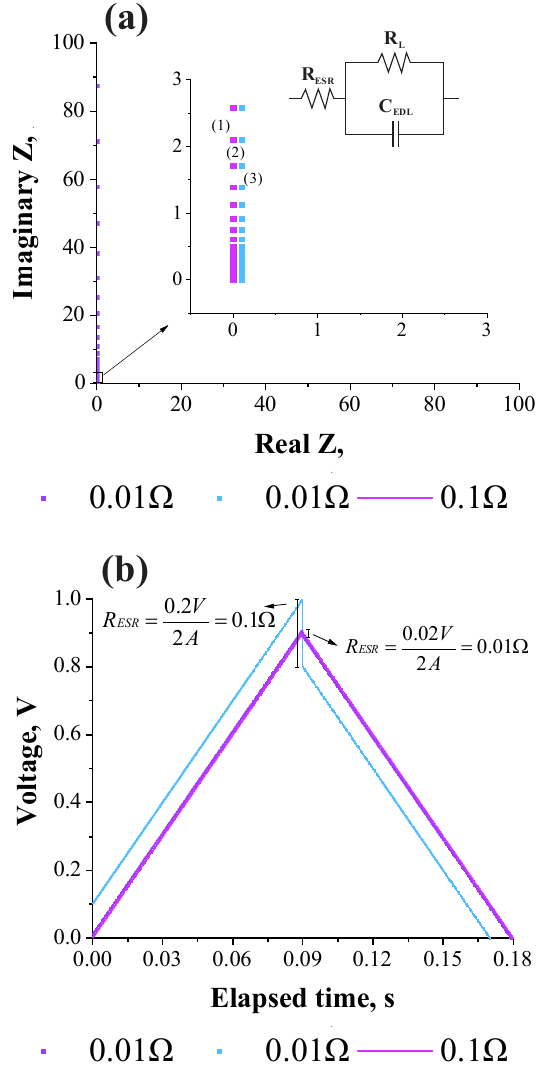
Figure 1. Schematic representation of ( a ) the complex-plane plots and ( b ) the galvanostatic charge-discharge curves evidencing the voltage drop ( U drop ). The inset in Figure 1a shows the canonic circuit model. Simulation was carried out considering different values of the R ESR and R L = 1 MΩ.